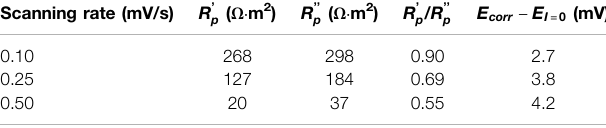
TABLE 2 | Effect of scanning rate on potential offset.